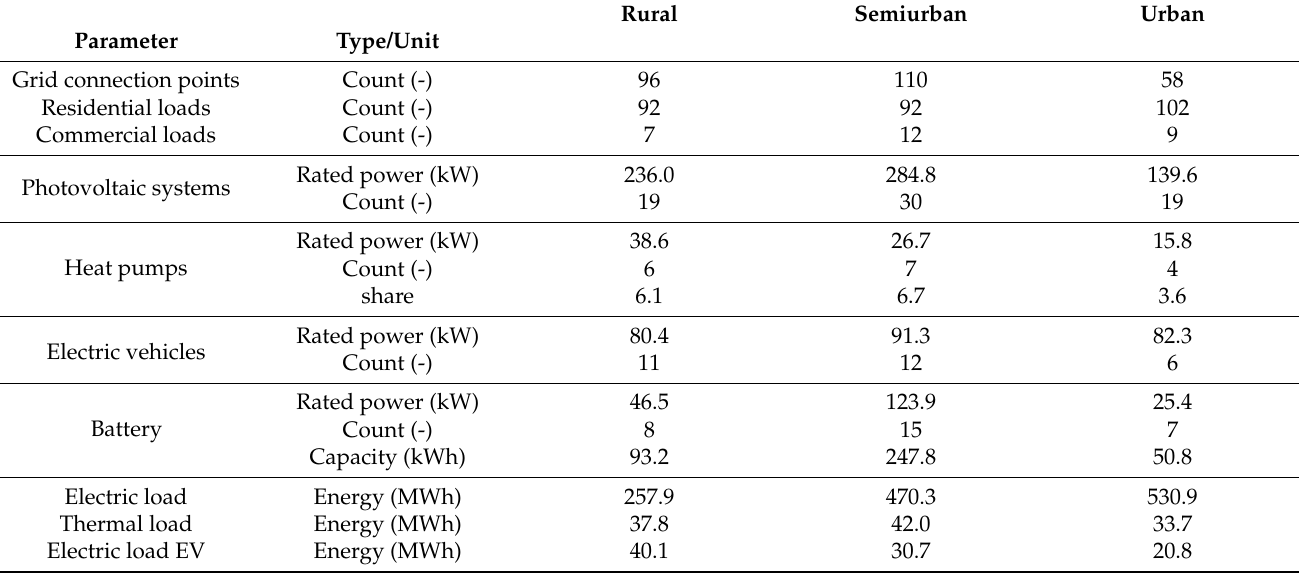
Table A2. Scenario assumptions for scenario year 2025, adapted from